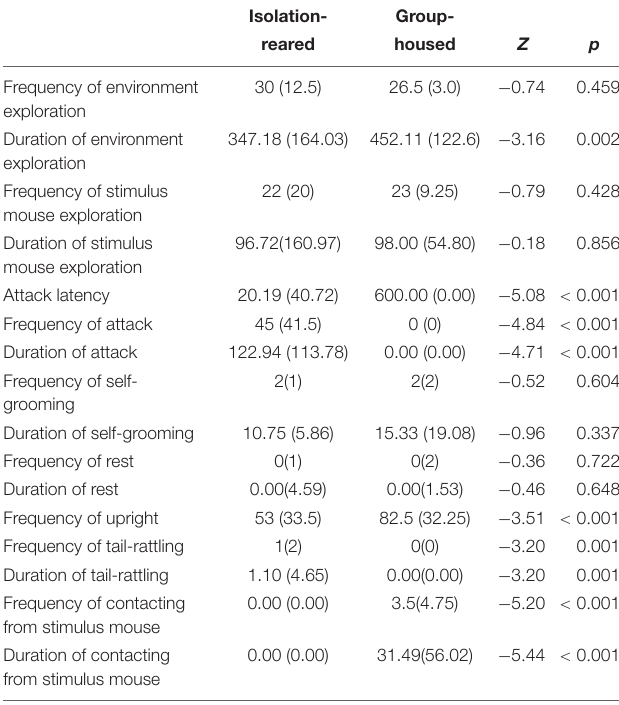
Frontiers in Behavioral Neuroscience |